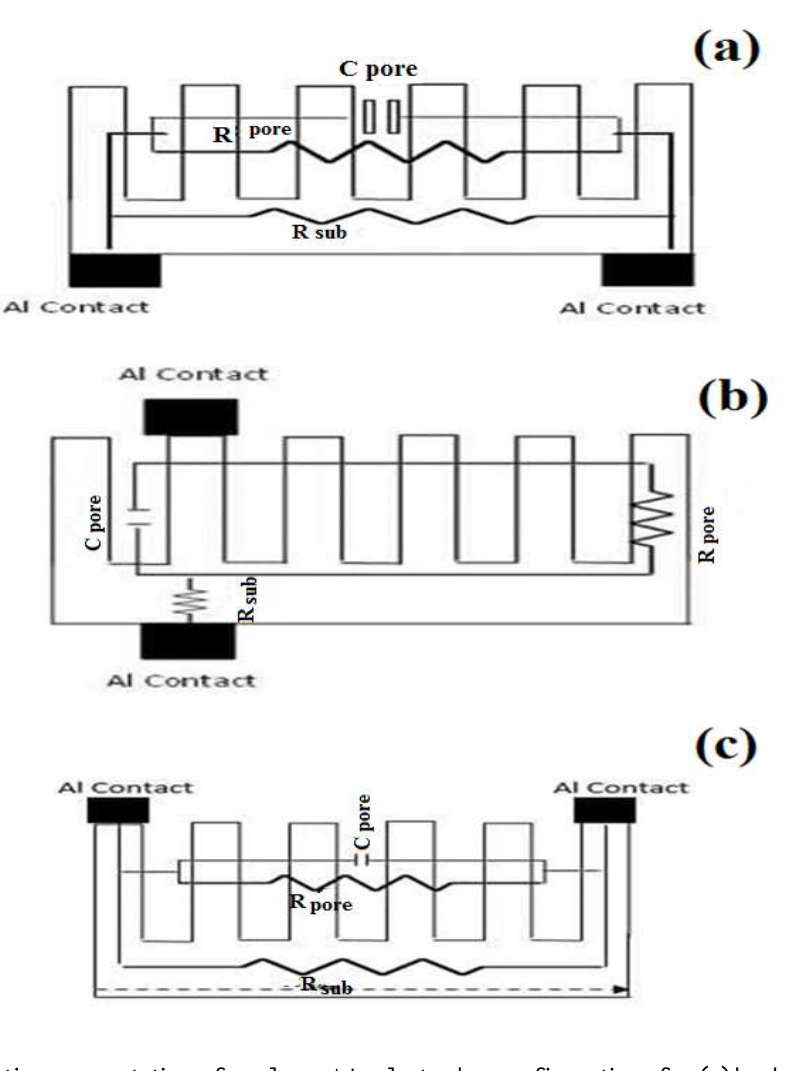
Figure 2: A schematic representation of coplanar AL electrodes configurations for (a) backside (S1), (b) front-